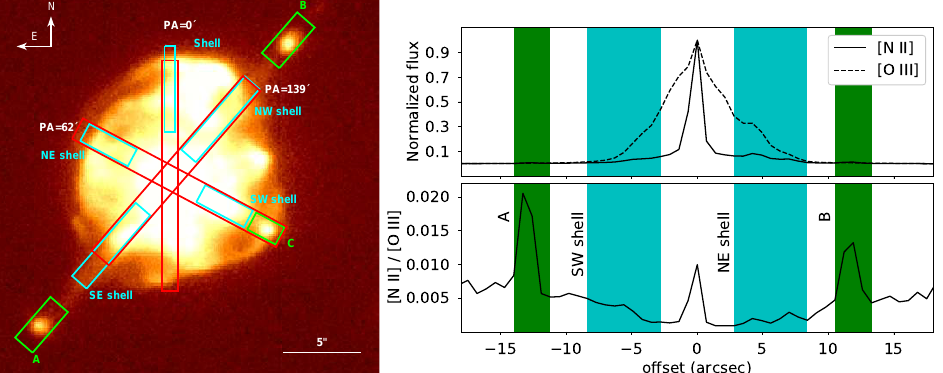
Figure 1. Left : The [N II ] image of IC 4593, from [18], on which the extraction windows of the different components are superposed as boxes, for the integrated emission (Neb; in red), the shells (in cyan), and the low-ionization species (LISs) (A, B, and C; in green). The extension of these nebular components are as follows. Neb has the same extension in all directions, 15 arcsec. PA= 0 ◦ : 5.6 arcsec, shell. PA = 62 ◦ : 3.5 arcsec, shells; 2.1 arcsec, C. PA = 139 ◦ : 6.3 arcsec, shells; 3.5 arcsec, for A and B. The slit lengths are > 13.7 arcmin for PA = 0 ◦ and 4 arcmin for PAs 62 ◦ and 139 ◦ . Right : The spatial profile of the [N II ] and [O III ] emission lines, normalized to 1.0, and the [N II ]/[O III ] line ratio, along the 139 ◦